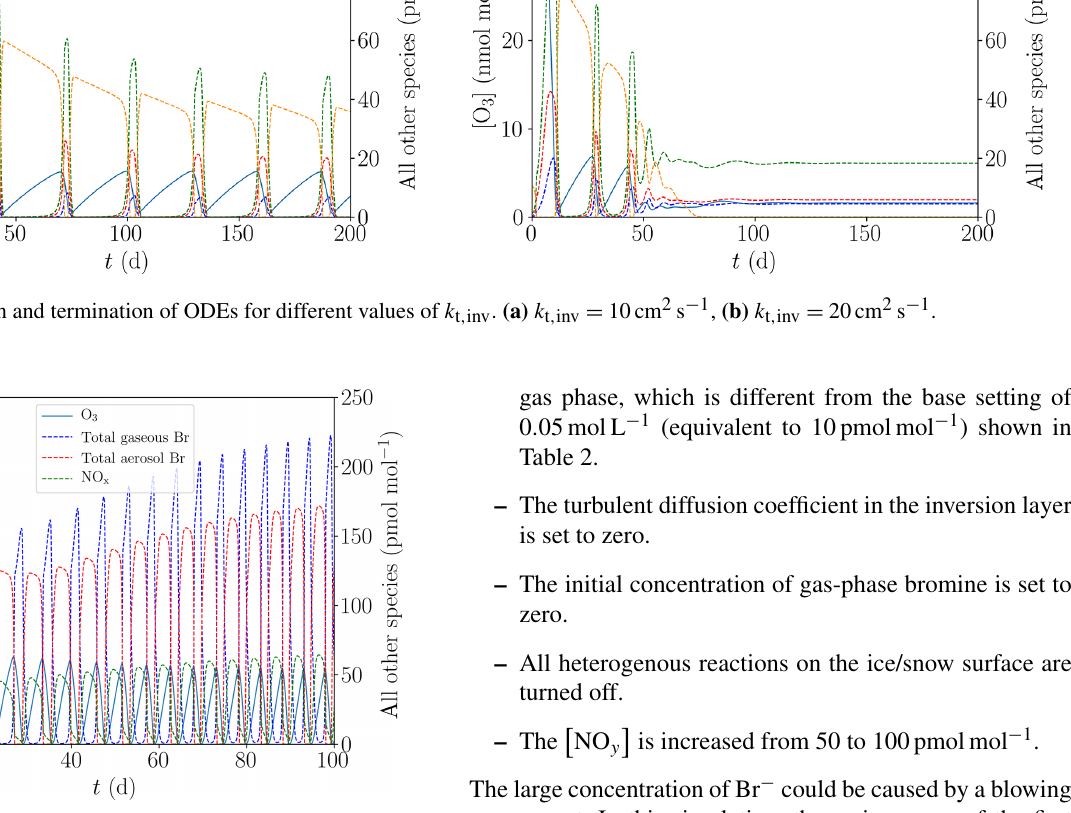
Figure 7. Evolution of O 3 , NO x , and total gaseous and aerosol bromine mixing ratios for the base case with (cid:2) NO y (cid:3) = 150pmolmol − 1